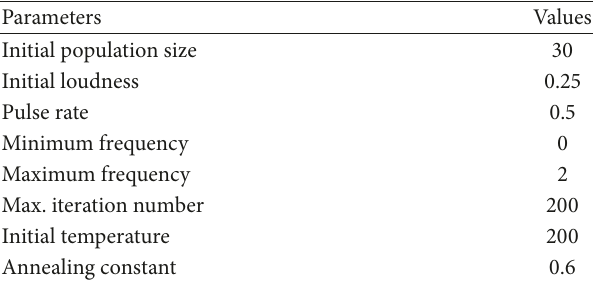
Table 3: Main parameters of the BAG-SA electricity demand estimation